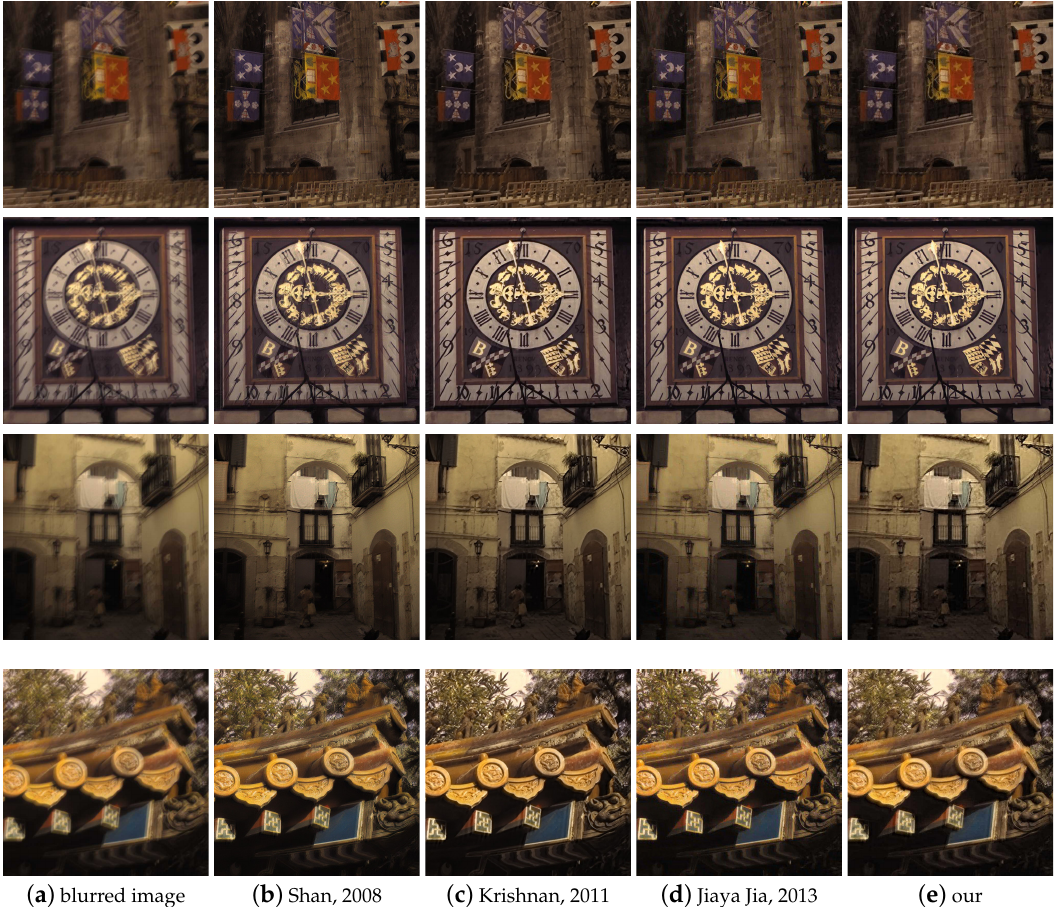
Figure 8. Experimental results with four methods: ( a ) blurred image; ( b ) Shan_2008. ( c ) Krishnan_2011; ( d ) Jia_2013; and ( e ) our proposed method.